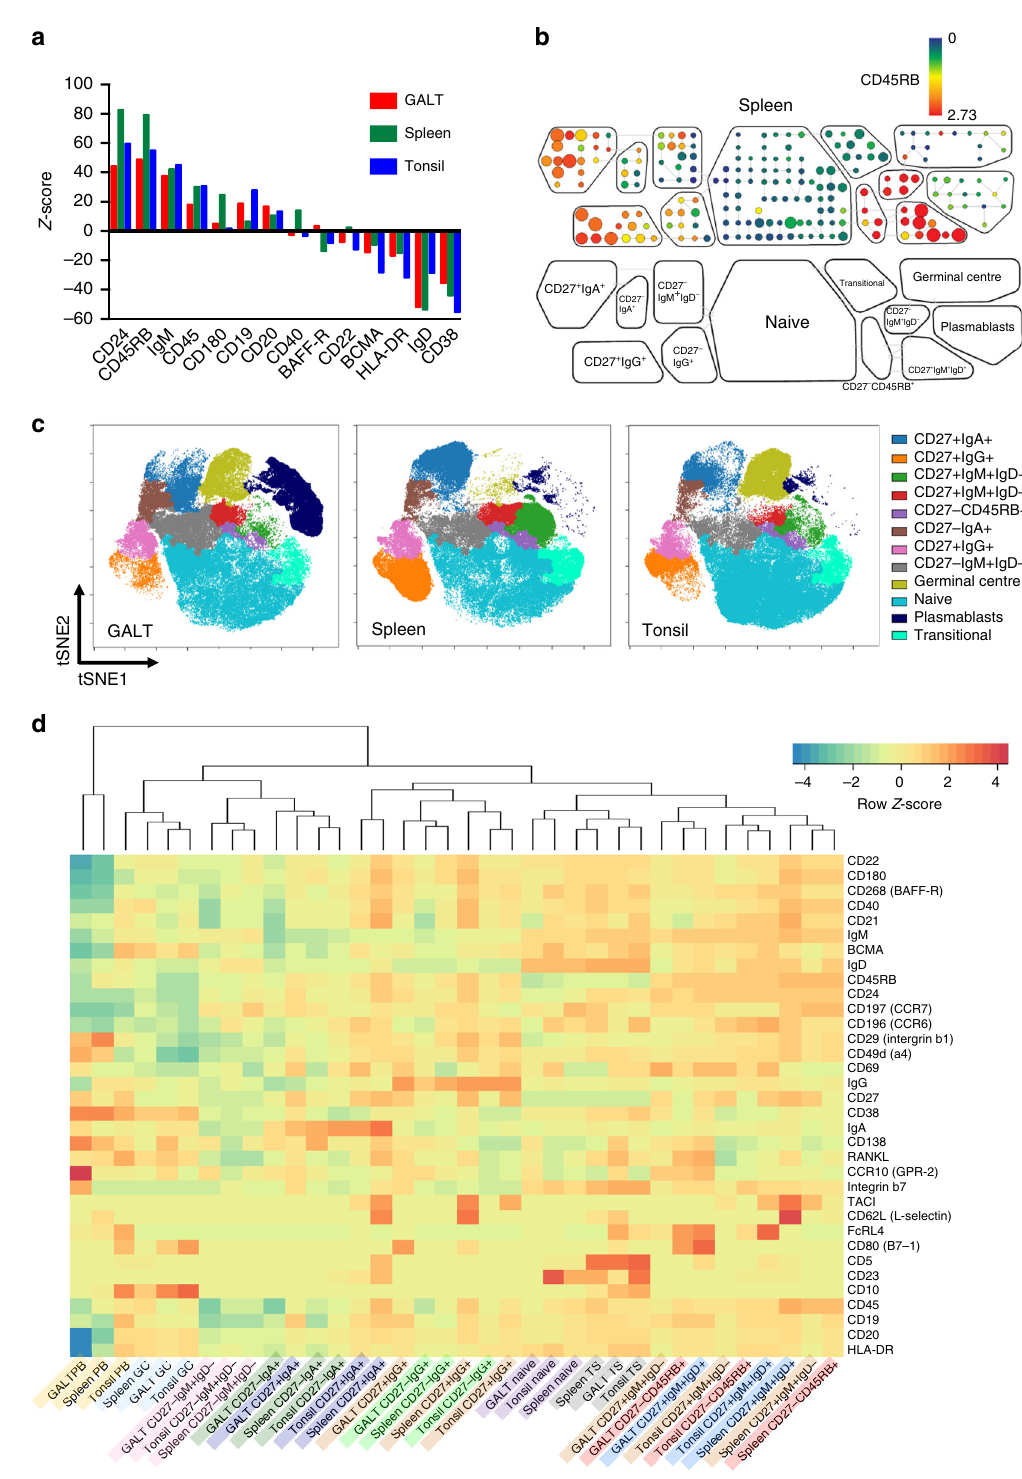
Fig. 2 CD27 − IgM + IgD + CD45RB + marginal zone precursor B cells emerge from the naïve B cell pool. Analysis of B cells in GALT ( n = 8); tonsil ( n = 5), spleen ( n = 6). a Z -score outcomes of a permutation test to determine if cell subpopulations signi fi cantly neighbour each other more than by random chance. This revealed that the CD45RB + cells were signi fi cantly different to the CD45RB - cells within the naïve B cell SPADE bubble by their over expression of CD24, IgM, CD45 in addition to CD45RB and lower expression of BCMA, HLA-DR, IgD and CD38. b A SPADE bubble was therefore placed around the CD27 − CD45RB + cells to be considered as a separate subset for inclusion in subsequent analysis, as illustrated for spleen. c All subsets (GC germinal centre, PB plasmablasts, TS transitional cells) were then visualised back on the viSNE plots for comparison where CD27 − IgM + IgD + CD45RB + cells were intermediate between naïve and CD27 + IgM + IgD + marginal zone subsets. d A separate hierarchical clustering method that considered all markers used for mass cytometry aligned CD27 − IgM + IgD + CD45RB + cells with CD27 + IgM + IgD + marginal zone cells and placed both closer to the naïve and transitional B cell subsets than conventional memory